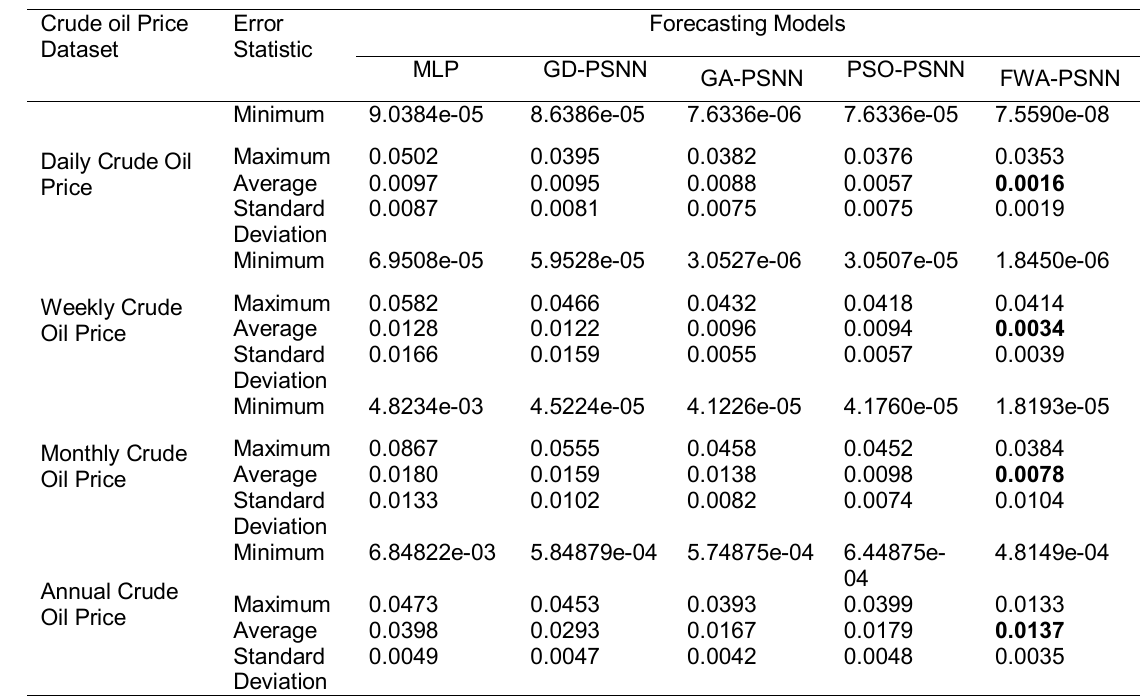
Table 3. Forecasting errors from all